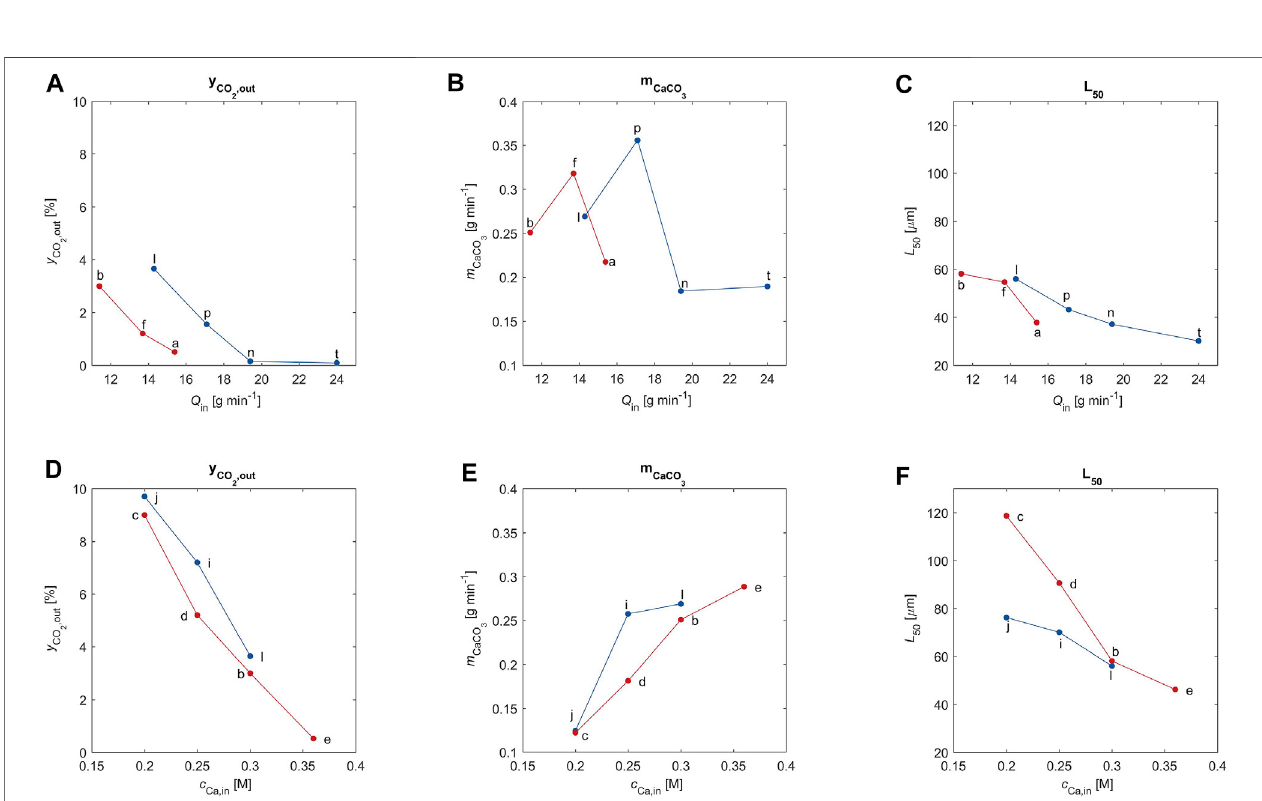
FIGURE4 | TheCO 2 outlet concentration, the CaCO 3 outlet fl owrate and the volume weighted average particle sizeare plotted asafunctionofthe liquid feed rate (subplot A – C ) and as a function of the calcium feed concentration (subplot D – F ). The letters correspond to the experimental ID of the data point according to Table 1 .